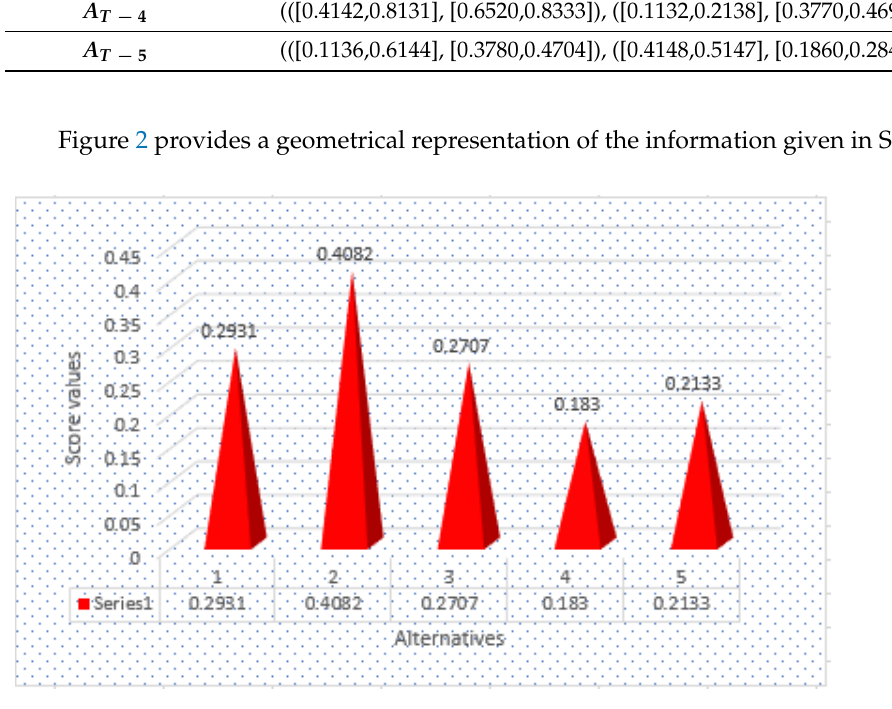
Figure 2. Geometrical representation of the aggregated